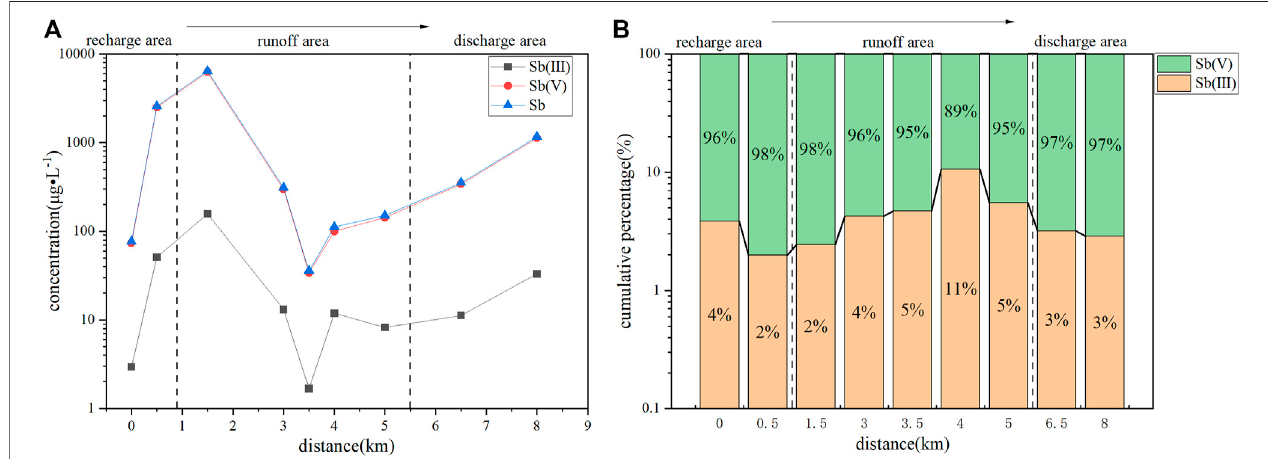
FIGURE 5 | (A) Spatial distribution of cations; (B) spatial distribution of anions.